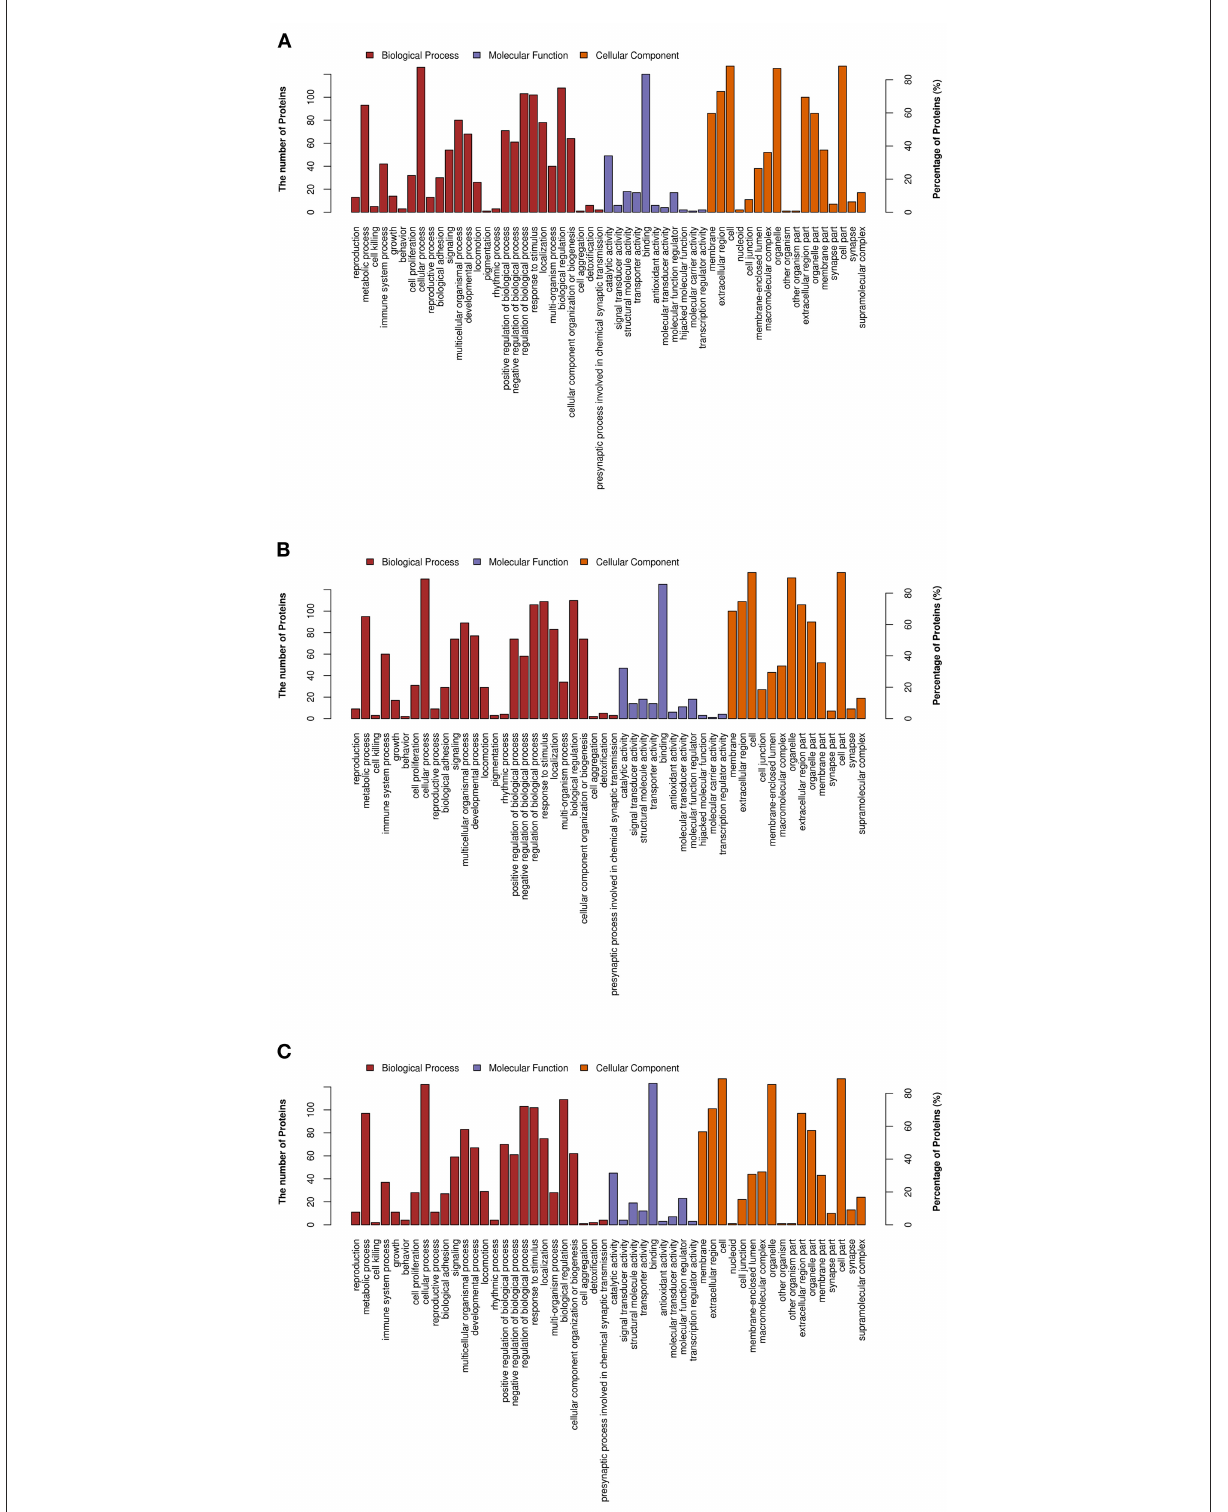
FIGURE3 Gene ontology (GO) annotation of differentially expressed MFGM proteins. (A) The GO analysis of differential proteins in MP/LP treatment; (B) The GO analysis of differential proteins in HP/MP treatment; (C) The GO analysis of differential proteins in HP/LP treatment.